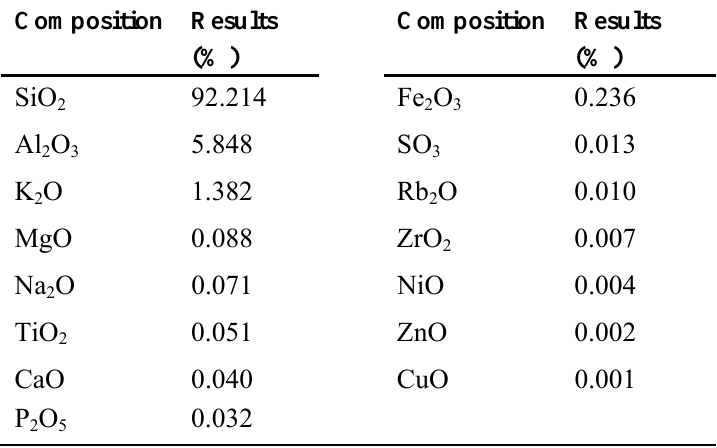
Table 1. Chemical composition of silica sand.